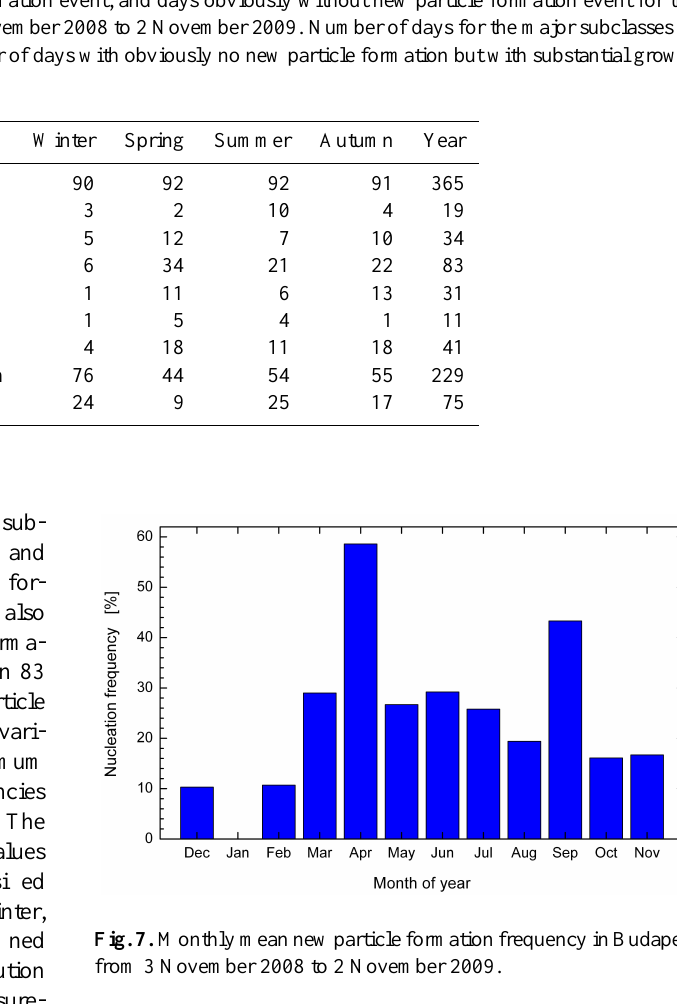
sonal variation of new particle formation are known to be related to local features, e.g., to solar radiation, air tempera- ture, relative humidity, biogenic emissions, local wind speed, boundary layer height, and concentration and size distribu- tion of atmospheric aerosol particles (V¨akev¨a et al., 2000; Kulmala et al., 2004a; Kiendler-Scharr et al., 2009). The new particle formation activity may be also associated with some limiting or triggering atmospheric processes in the ac- tual region. The reasons for new particle formation events in Budapest, relationships between their properties, pollutant gases and meteorological variables are to be dealt with in a separate